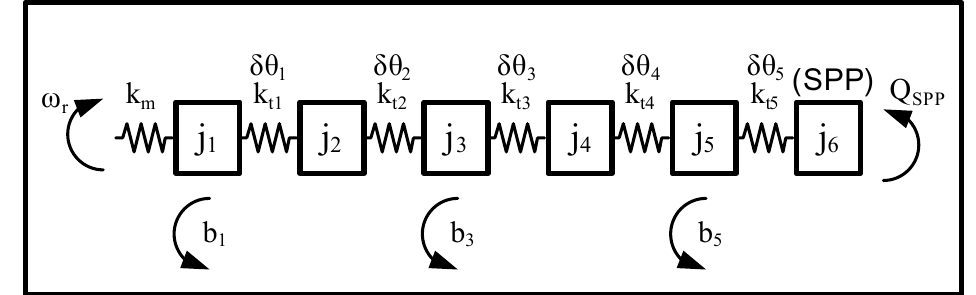
Figure 12. Shafting vibrational model mechanical system.